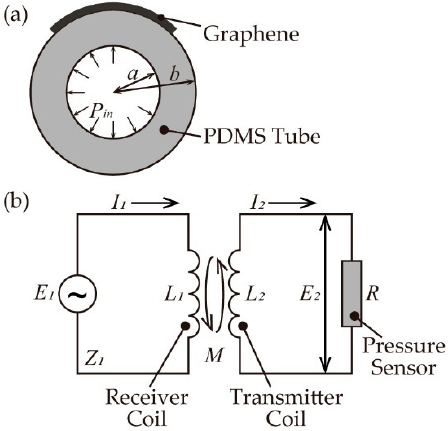
Figure 2. The principle of our proposed sensor. ( a ) Schematic cross-sectional diagram. ( b ) Schematic circuit diagram.